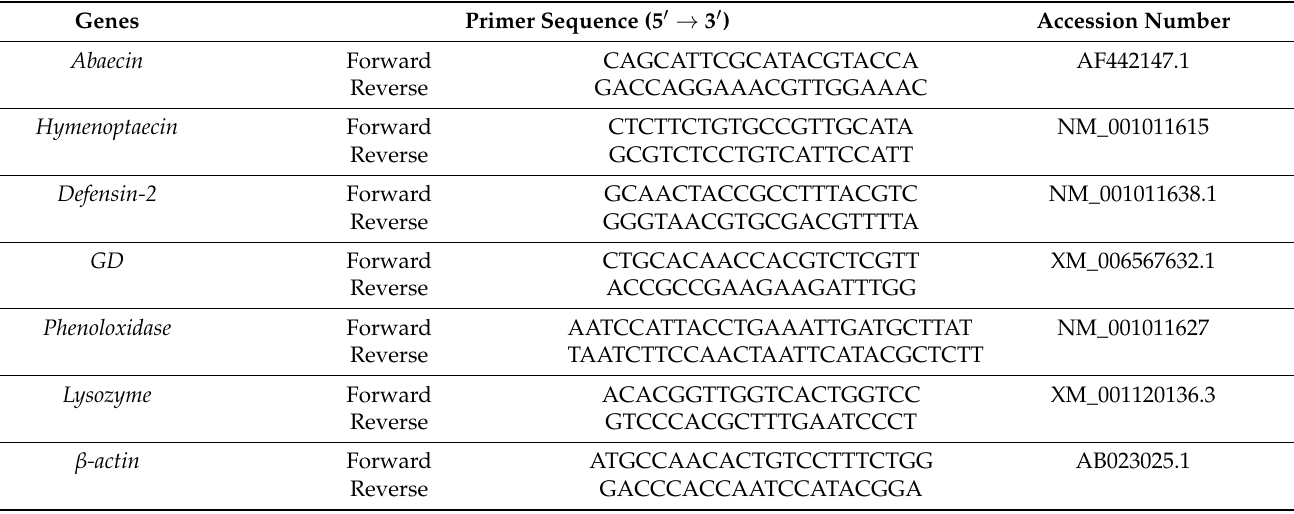
Table 1. Primer list for